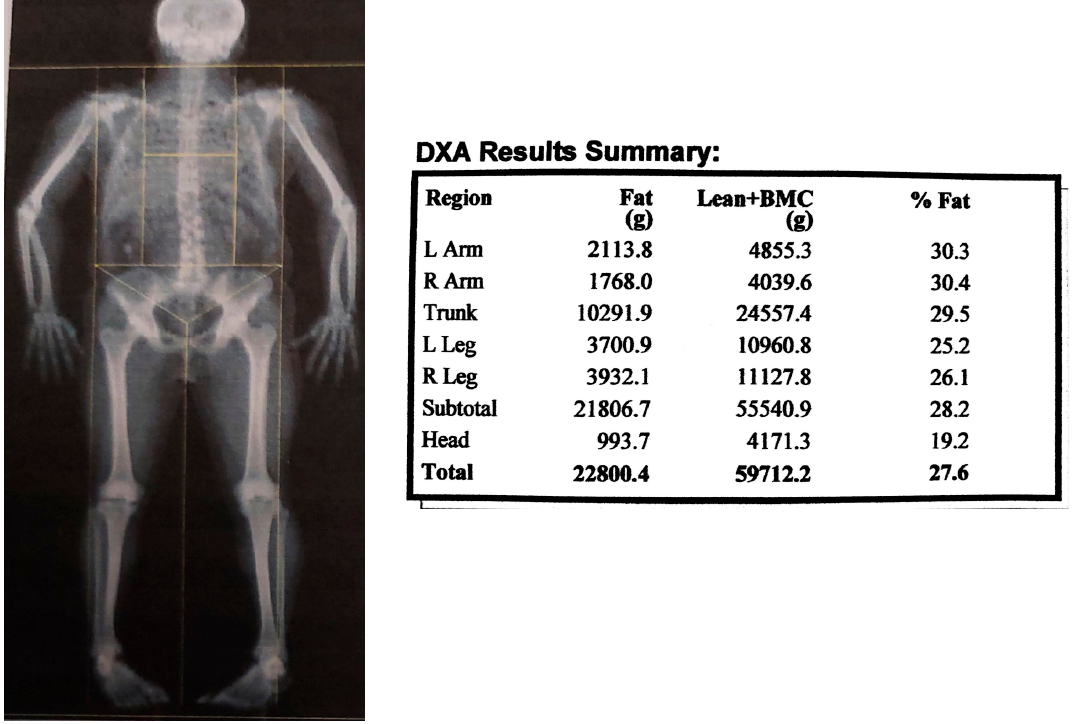
Figure 1. ( a ) Dual X-ray absorptiometry (DXA) scan and ( b ) DXA results summary. Table 1. Demographic characteristics and mean values of obstructive sleep apnea (OSA), nutritional status assessment, body composition and systemic inflammation parameters in test